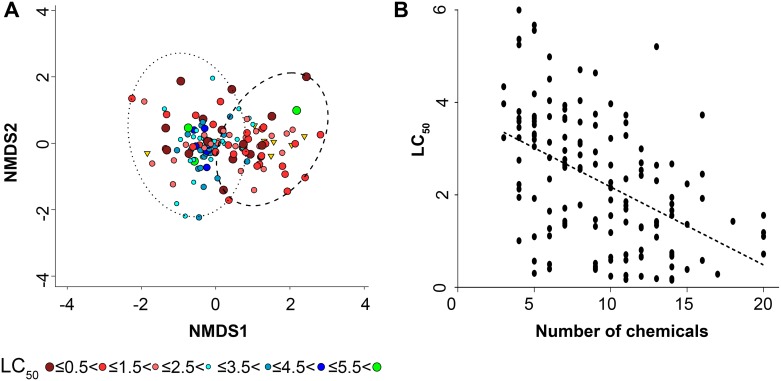
The presence/absence of e-liquid constituents and their toxicity have some correlation.(A) NMDS of e-liquids chemical analysis (presence/absence). NMDS was performed using binary Euclidean distances (stress 0.1367). E-liquids are shown as circles of varying size and color. Dashed circles encompass e-liquids within the same k-mode cluster, showing a significant separation of, in general, high and low LC50 e-liquids. Chemicals within each cluster were compared using a t test, in which resultant p-values were adjusted using Bonferroni correction. Chemicals within e-liquids are represented as triangles; gold coloration denotes those to be significantly (p < 0.0004) present after multiple testing correction and may be associated with lower LC50 values. (B) Graph showing toxicity (LC50) versus the number of chemicals in each e-liquid. Pearson correlation = −0.48; R2 = 0.23. Raw data are available in S6 Data. LC50, concentration at which a given agent is lethal to 50% of the cells; NMDS, nonmetric multidimensional scaling.